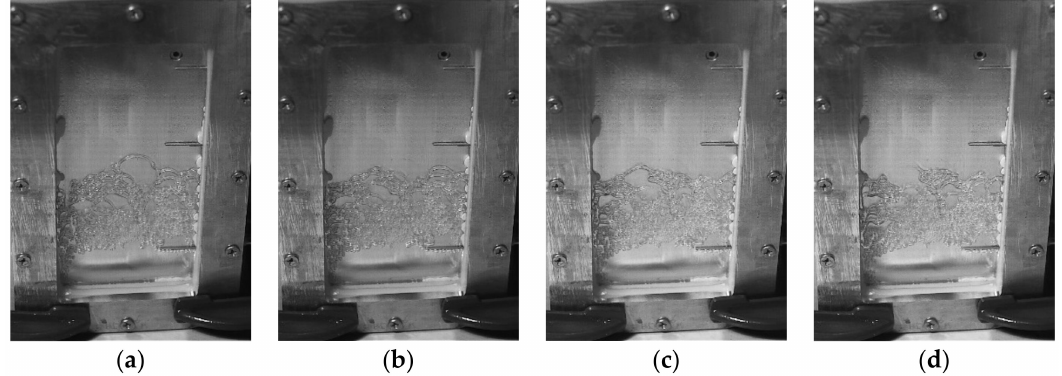
Figure 21. Typical images of gas-liquid two-phase hydrodynamic behavior in the cavity of the PGHP (FR = 25%, Q in = 140 W, ∆ t = 18 ms), ( a ) hydrodynamic behavior at 0 ms; ( b ) 18 ms; ( c ) 36 ms; ( d ) 54 ms.